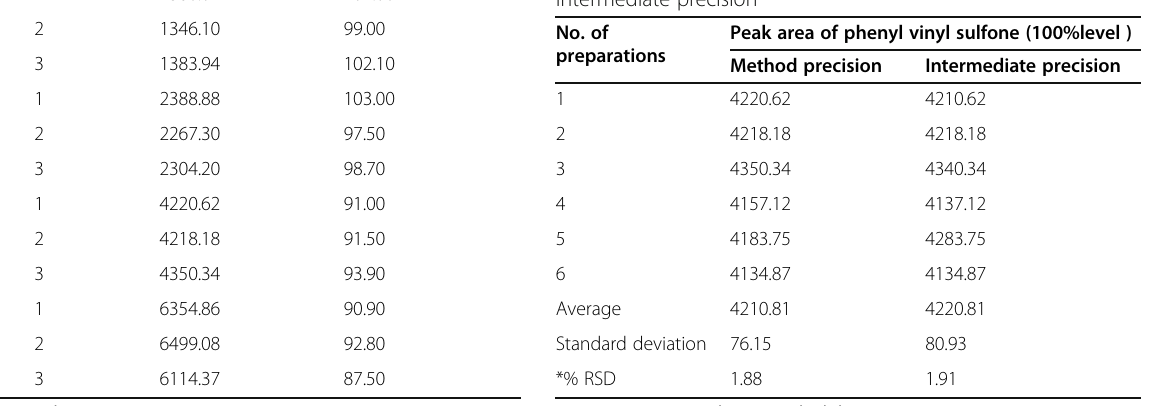
Table 5 Summary of results for method precision